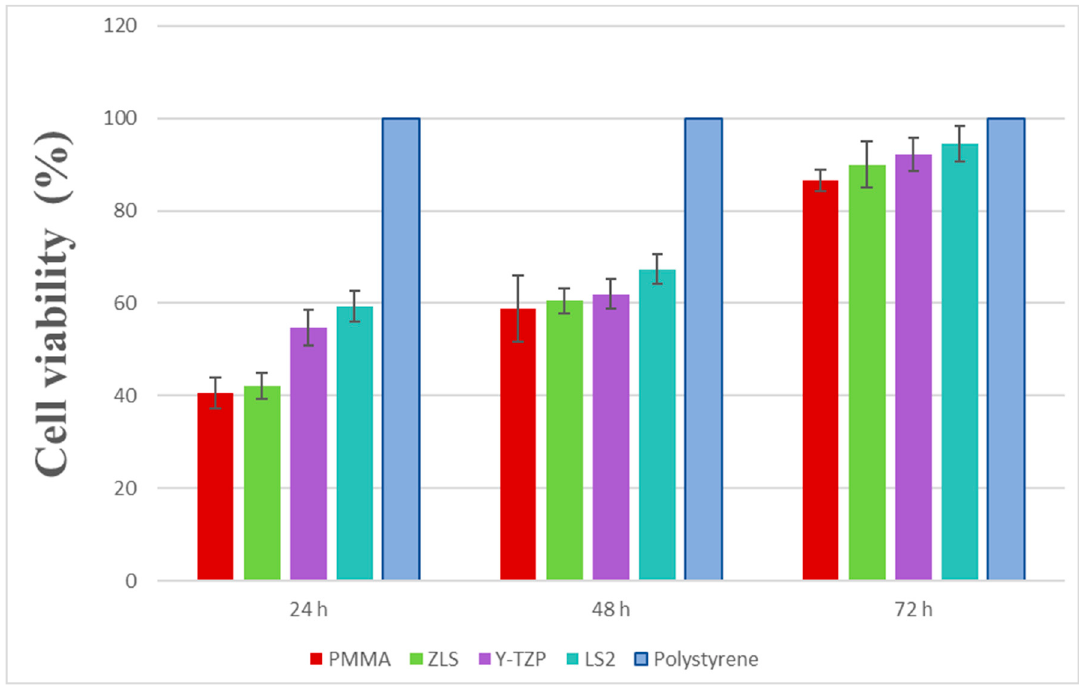
Figure 3. Cell viability percentage at 24, 48, and 72 h using MTT assay. The data are expressed as the mean values ± standard deviation.